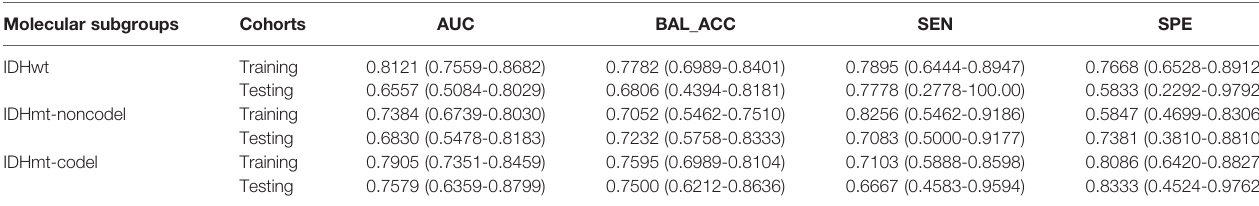
TABLE 3 | Summary of the subtype-speci fi c classi fi cation performance of the radiomics model. Molecular subgroups